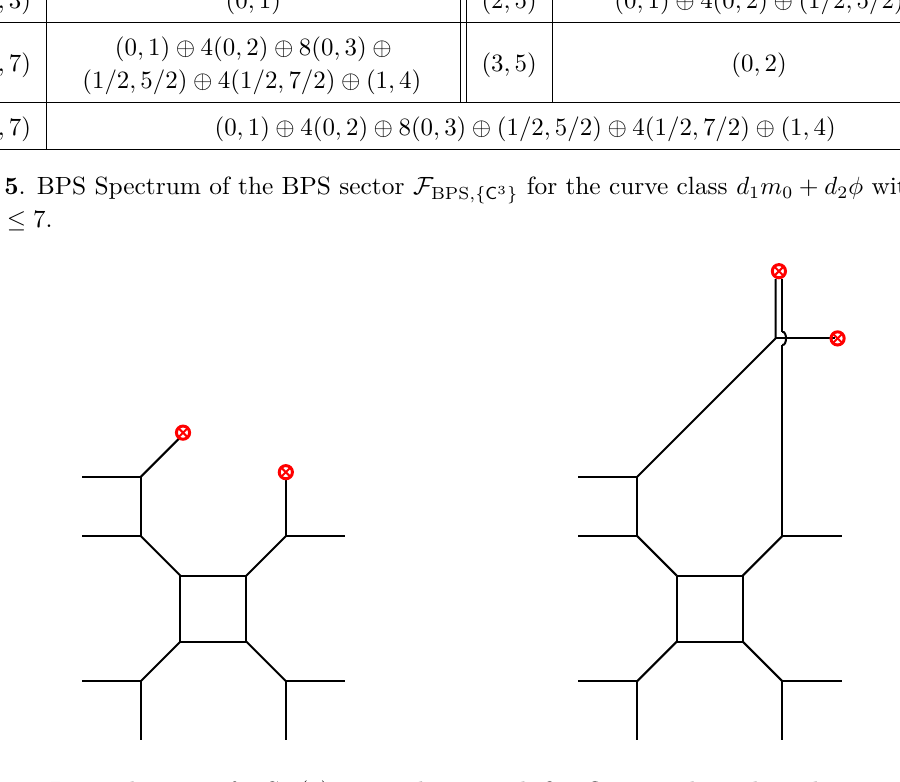
Figure 7 . Brane diagrams for SU(2) gauge theory with five flavors, where the red points stand for the 7-branes spanned over x 0 , 1 , 2 , 3 , 4 , 7 , 8 , 9